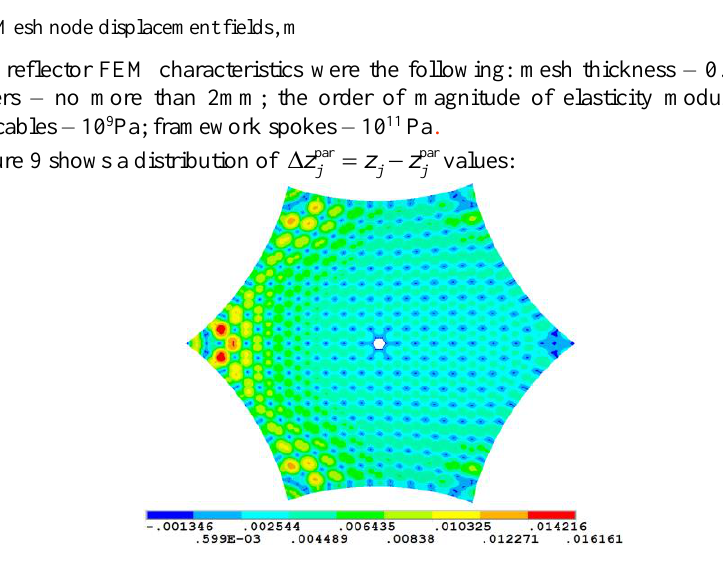
Fig. 9. Distribution of p a r z  values in the reflective mesh, m j zz u  , FE M u – node coordinate of FEM and mesh node displacement z , z where, FE M z jjj j j on z-axis respectievly; – node coordinate on the theoretical offset parabolic surface; j =1… N – node number.